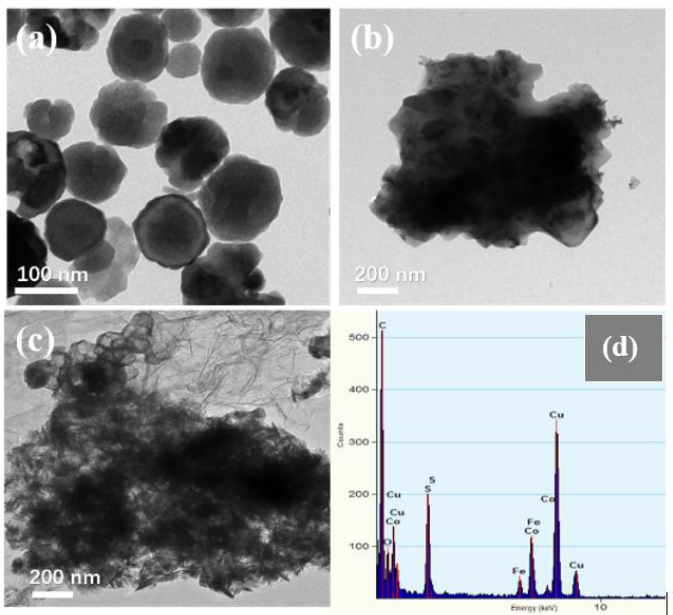
Figure 4. Transmission electron microscopy (TEM) images of Fe 3 O 4 ( a ), CoS ( b ), CoS@Fe 3 O 4 @rGO ( c ), and its corresponding energy-dispersive X-ray spectrometry image ( d ).